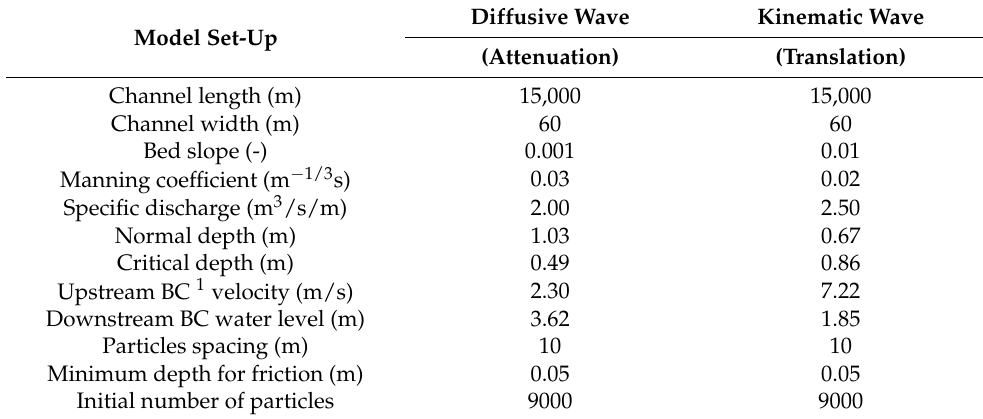
Table 2. Wave propagation model set-up